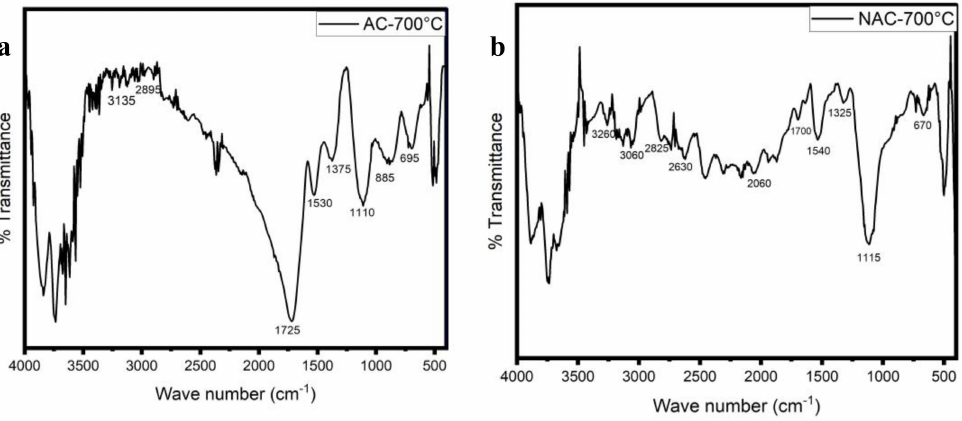
Figure 4. FTIR spectra of ( a ) AC-700 ◦ C and ( b ) NAC-700 ◦